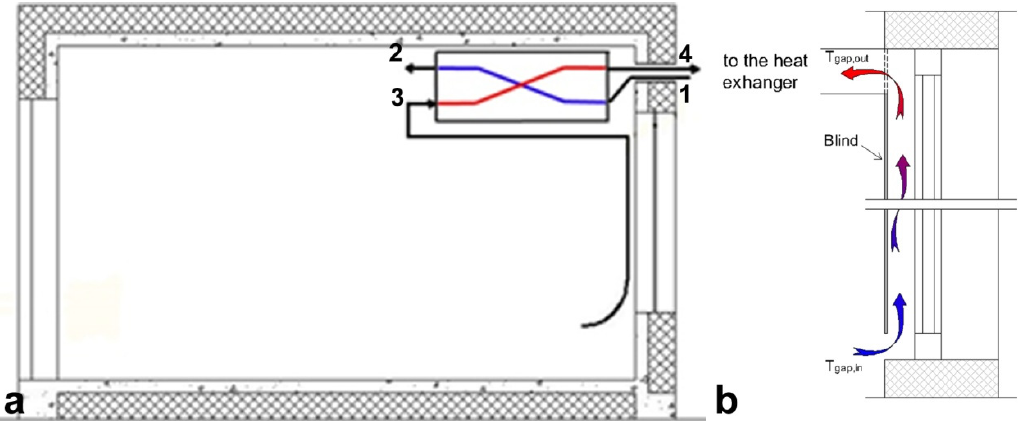
Figure 3. ( a ) Section of the overall system; ( b ) Section of the air flow through the air gap.